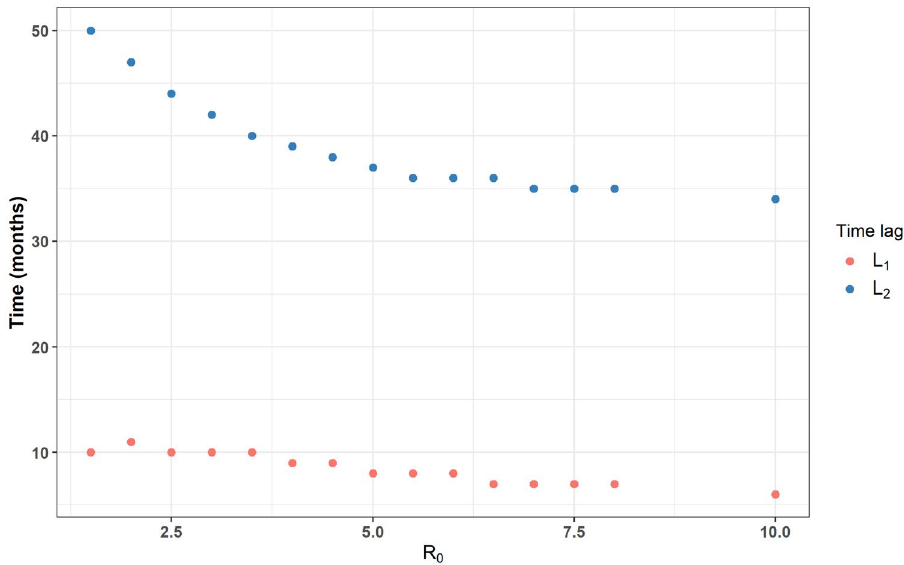
Figure 4. Lag times L 1 (between test results TR 2 and TR 1 ) and L 2 (between test results TR 3 and TR 1 ) as a function of R 0 .